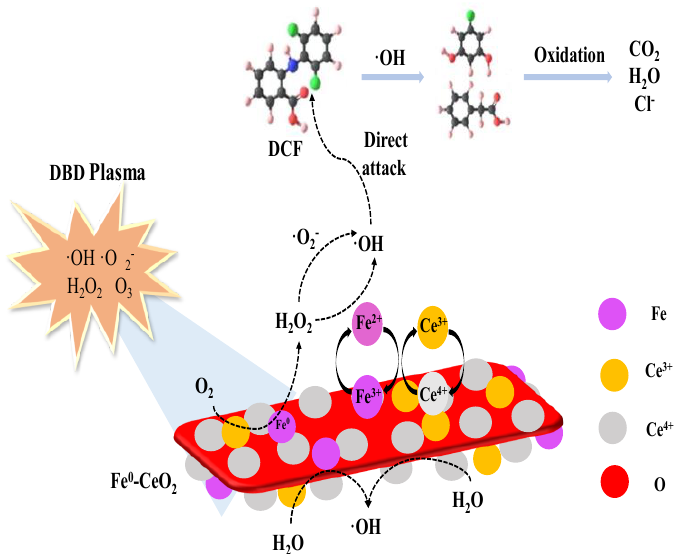
Figure 9. Mechanism of the degradation of DCF by DBD system-Fe0-CeO 2 system